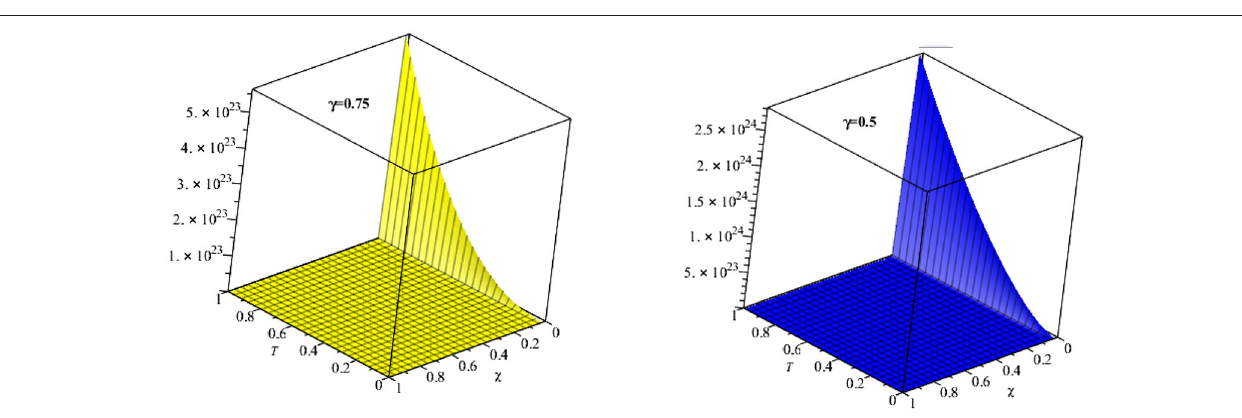
FIGURE 7 | Represents the solution of example 4.4 at γ = 0.75, γ = 0.5.